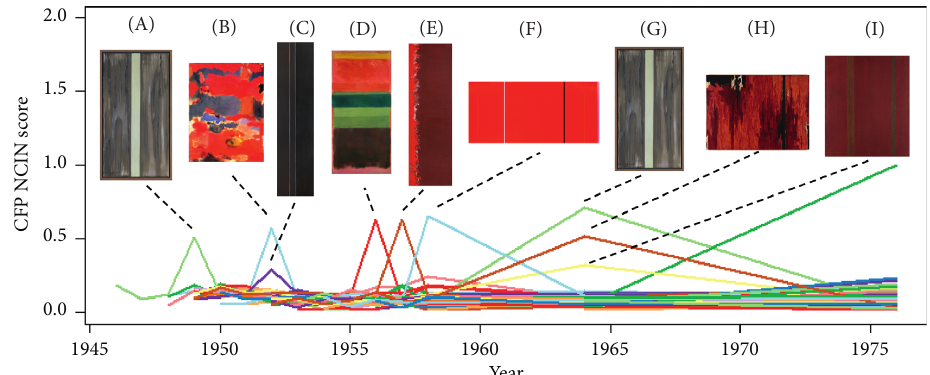
Figure 19: Time series of creativity scores based on network N for Color Field Painting artworks. (A) Barnett Newman: Moment (1946). 3 (B) Mark Rothko: Untitled (1948). (C) Barnett Newman: By Tows (1949). (D) Mark Rothko: Untitled (1949). (E) Barnett Newman: Untitled 3 (1949). (F) Barnett Newman: Vir Heroicus Sublimis (1950–1951). (G) Barnett Newman: Moment (1946). (H) Clyfford Still: Untitled (1951–1952). (I) Barnett Newman: Galaxy